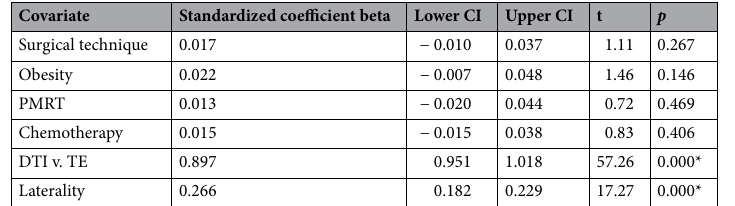
Table 7. Multivariable linear regression analysis of cost ratio. This table shows a multivariable linear regression based on covariates that are known risk-factors of post-operative complications in breast reconstruction. The regression found independent associations of both laterality and reconstructive staging with cost ratios. The regression utilized a confidence interval of 95% and demonstrated strong linearity with an adjusted R square value of 0.871. *Statistically significant ( p < 0.05). PMRT post-mastectomy radiation therapy, DTI direct-to-implant, TE tissue expander, CI confidence interval (95%). Adjusted R 2 = 0.871; Standard Error of the Estimate = 0.135. Surgical technique defined as sub- and pre-pectoral breast reconstruction. Chemotherapy included both neoadjuvant and adjuvant therapy. Laterality included unilateral and bilateral breast